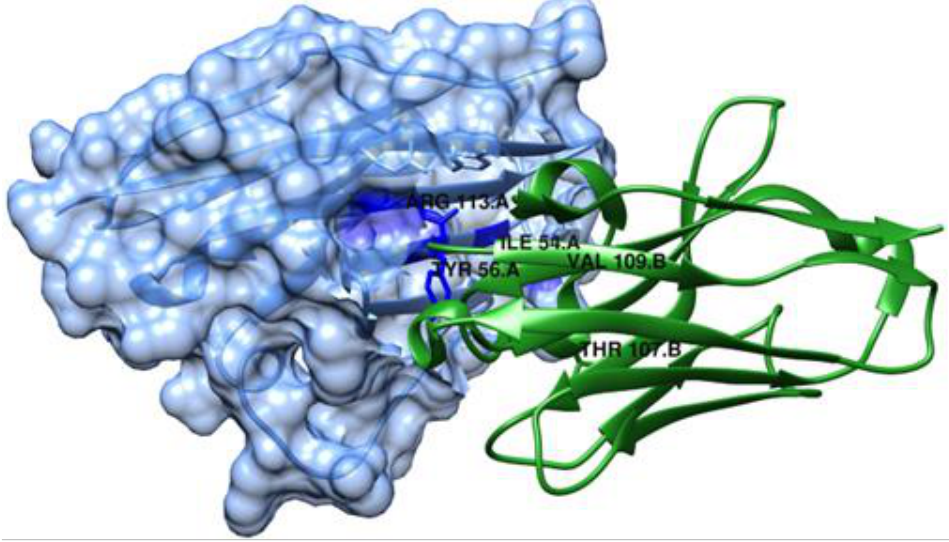
Figure 12. Structure of the KN035/ PD-L1 complex (PDB ID: 5JDS) represented using UCSF Chimera [58,99]. PD-L1 is shown as a slate, semi-transparent surface.